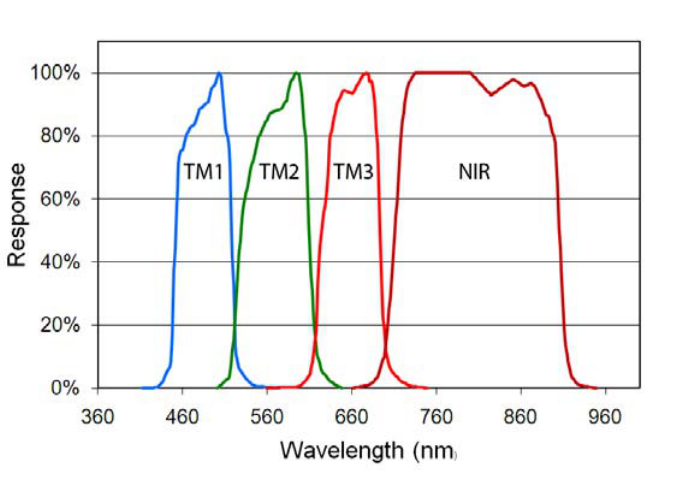
Figure 4. Set of four spectral bands based on the Landsat Thematic Mapper (TM). Note that the short wavelength edge of the near infrared TM band (NIR) was shifted to 700 nm. An additional orange spectral band was formed by merging the green (TM 2) and red (TM 3)